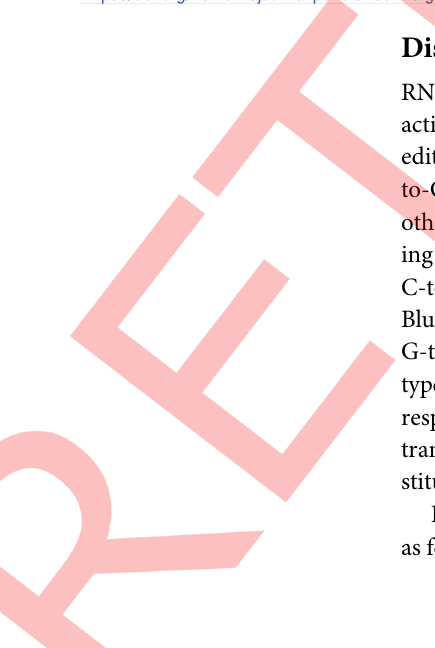
Fig 2. Genome wide distribution of RESs. Each circle represents the number of all RESs from outside to inside for Batis (G1), Blue Silver (G2), Chakwal 50 (G3), Local White (G4), Syn-22 (G5), and UZ-11-CWA-8 (G6) genotypes.